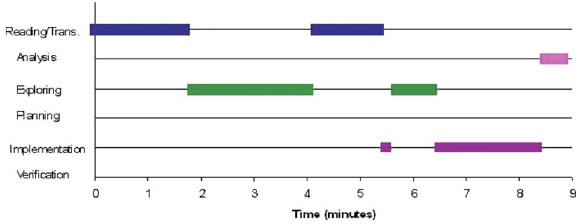
FIG. 5. (cid:1) Color online (cid:2) Schoenfeld-style diagram for a novice student’s unsuccessful attempt at the electrostatics challenge prob- lem. Note the lack of planning or analysis.